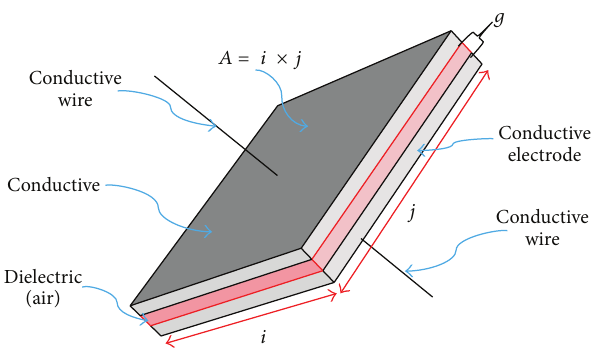
Figure 1: The schematic view of a unit parallel plate actuator ( 𝑖 = width, 𝑗 = height).